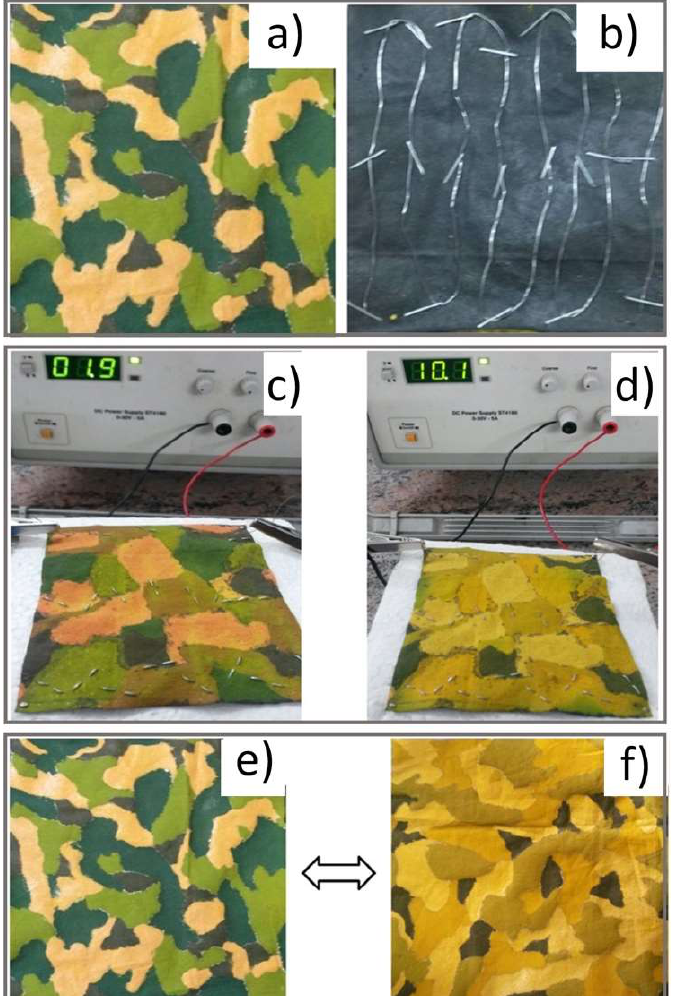
Figure 3. ( a ) The active side of camouflage fabric printed using thermochromic colorants. ( b ) The back side of the camouflage fabric coated with thermoplastic polyurethane layer containing liquid exfoliated graphite. The back side was also stitched with nichrome wires. ( c , d ) The change in color under applying 2 and 10 voltages, respectively. ( e , f ) The change in color of the camouflage patterns with and without heating at 60 °C for 2 minutes (reprinted from [39], ©The Textile Institute, with permission of Informa UK Limited, trading as Taylor & Francis Group, on behalf of The Textile Institute).